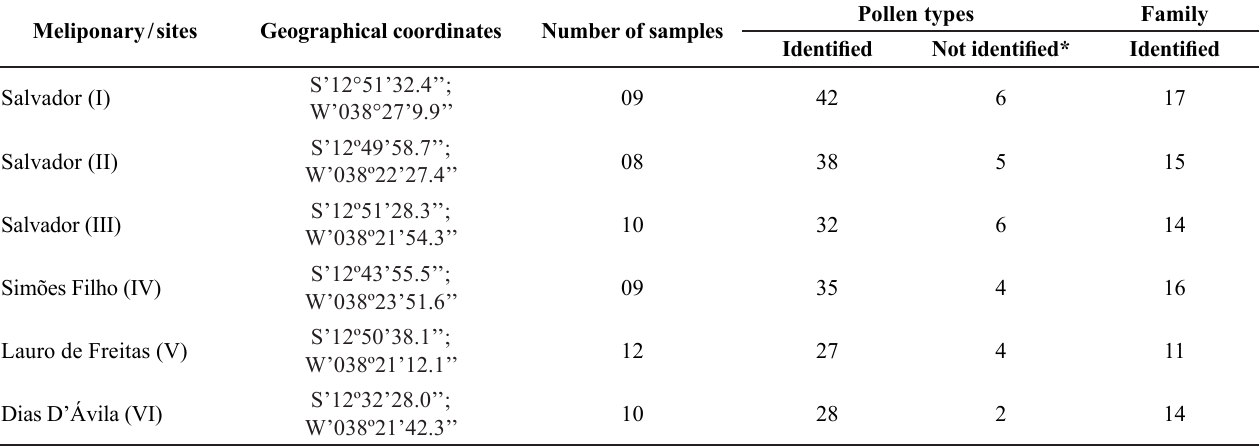
Table 2. Number of honey samples of Melipona scutellaris per meliponary and associated pollen types and plant families, in highly urbanized and industrialized sites in the Metropolitan Region of Salvador, Bahia, Brazil.